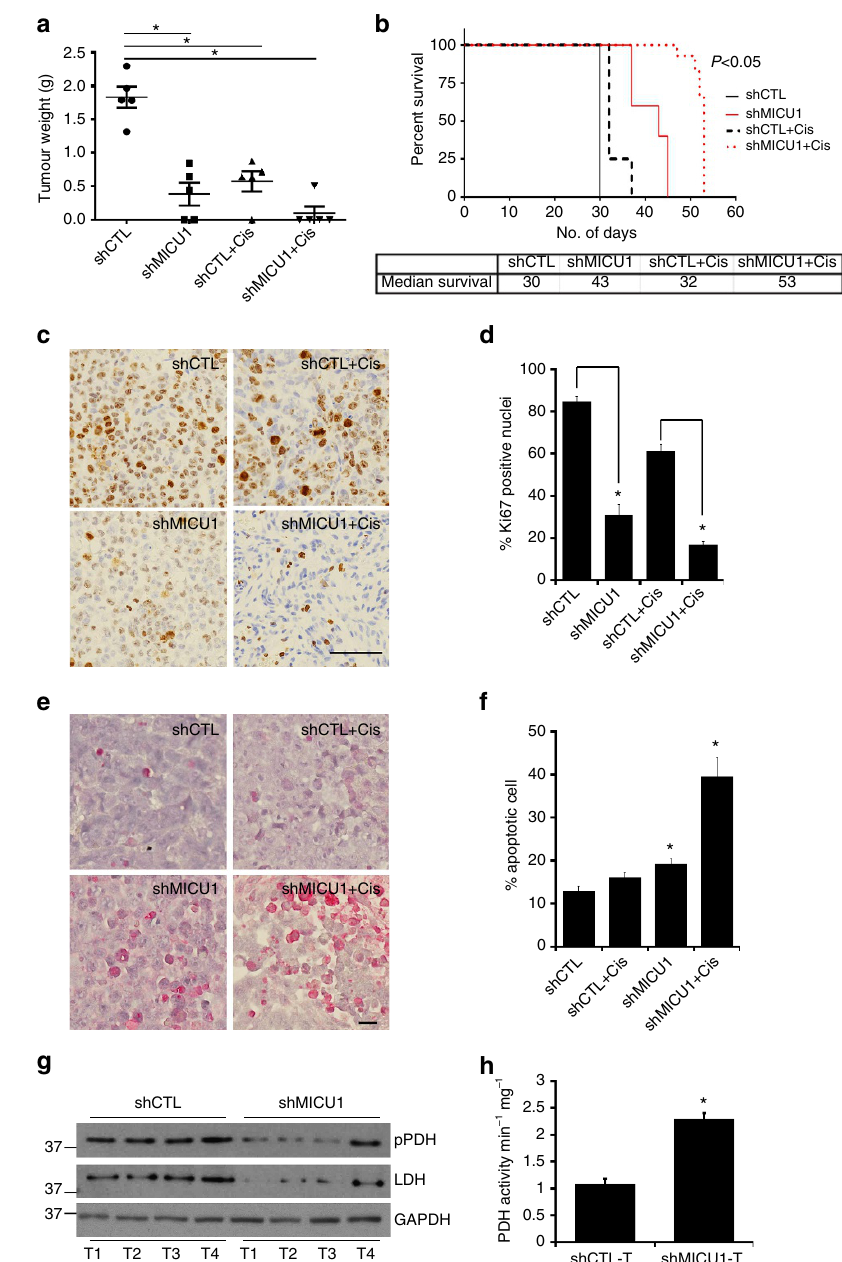
Figure 7 | Effect of MICU1 knockdown on tumour growth and drug resistance. ( a )To assess the effects of knockdown of MICU1 on tumour growth, treatment with cisplatin was initiated 1 week after i.p. injection (1.0 (cid:2) 10 6 shCTL- or shMICU1-OV90) of tumour cells. Mice were divided into four groups ( n ¼ 10 mice per group): (i) shCTL, (ii) shCTL þ cisplatin (160 m g per mouse i.p. twice weekly), (iii) shMICU1 and (iv) shMICU1 þ cisplatin (160 m g